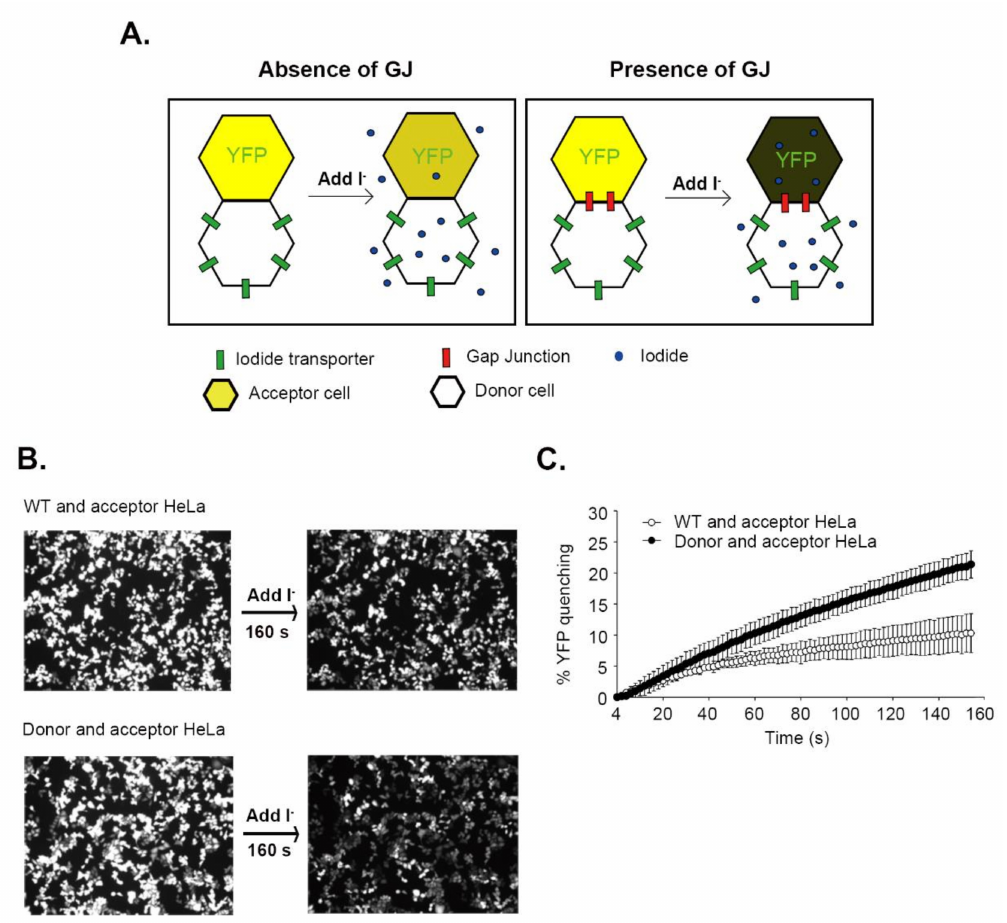
Figure 1. I-YFP assay revealed GJIC activity in HeLa cells. ( A ) A schematic presentation of the I-YFP GJIC assay. The yellow hexagon is an acceptor cell stably expressing YFP QL , a YFP variant whose fluorescence is quenched by iodides. The white hexagon with green rectangles is a donor cell that expresses SLC26A4, an iodide transporter. If donor and acceptor HeLa cells are connected by GJs (red rectangles), added iodides go through SLC26A4 and GJs and quench the YFP in the acceptor cell. If HeLa cells do not express functional GJs, iodides can enter the donor cell but cannot di ff use to acceptor cells. A single iodide in the acceptor cell of the left panel denotes non-specific and slow iodide influx into the HeLa cell. The degree of YFP quenching is presented as a dark yellow color in the acceptor cells. ( B ) Fluorescence images of the I-YFP GJIC assay in HeLa cells. The acceptor HeLa cells combined with WT (top) or donor (bottom) HeLa cells were plated on a six-well plate. After a 24-h incubation, the culture media were replaced with 1 mL of C-solution. The fluorescence images were taken before and 160 s after adding 1 mL I-solution on a fluorescence microscope (Observer.D1, Zeiss). ( C ) I-YFP GJIC assay in HeLa cells. WT and acceptor HeLa cells or donor and acceptor HeLa cells were mixed at a ratio of 4:1 and plated on 96-well plates before the I-YFP GJIC assay. The YFP quenching percentage was plotted against assay time. The data are expressed as the mean ± SD ( n =